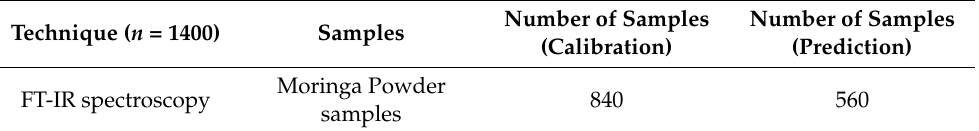
Table 4. Datasets used during model construction.